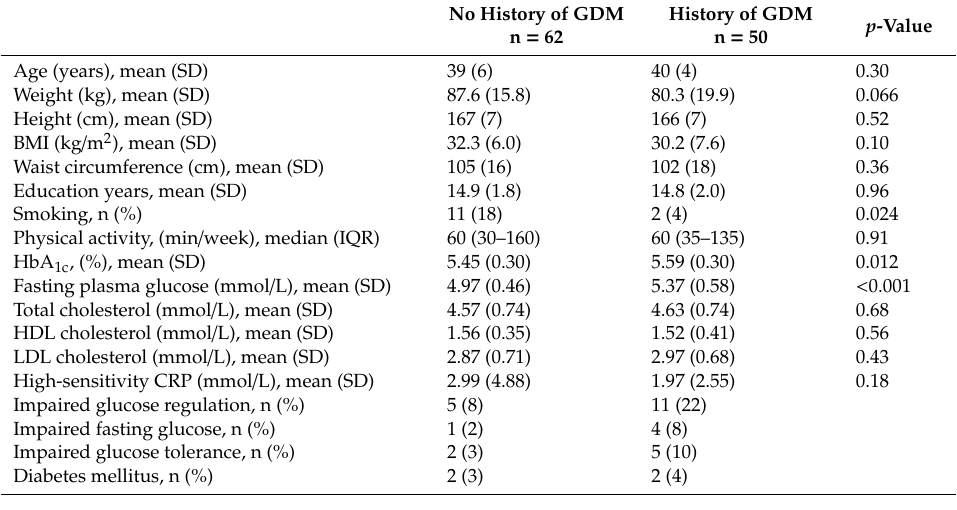
Table 1. Baseline characteristics of the study participants with and without a history of gestational